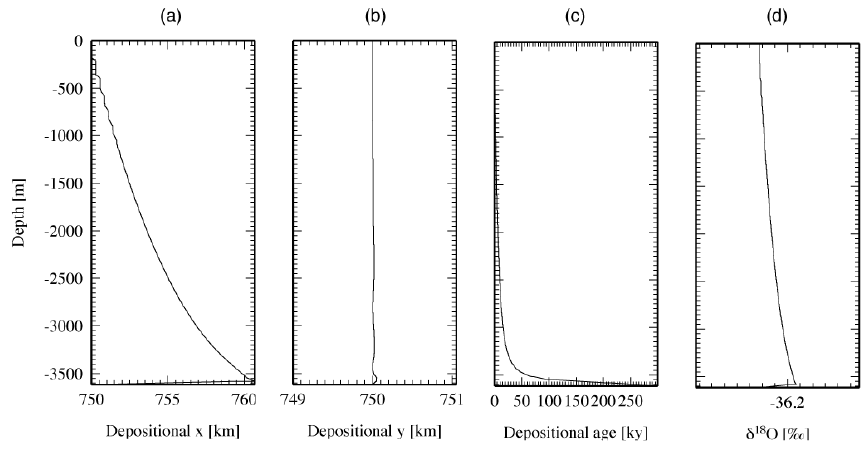
Figure 11. Simulated ice core C1 at x = 750km, y = 750km, with (a) depositional x (km), (b) depositional y (km), (c) depositional age (kyr), and (d) δ 18 O value.